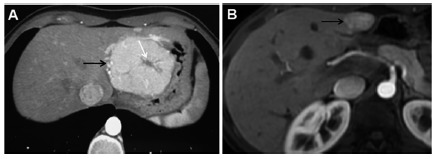
A) Arterial phase of a CT exam in a patient with typical FNH (black arrow) where a hypodense central scar can be observed in the center of the lesion (white arrow); B) arterial phases of MRIs in young patients with atypical arterialized lesions (white arrows) in steatotic liver where homogeneous emphasis of the lesions can be observed; control examinations at 24 months showed stability of the lesions, which were therefore considered "most likely benign"